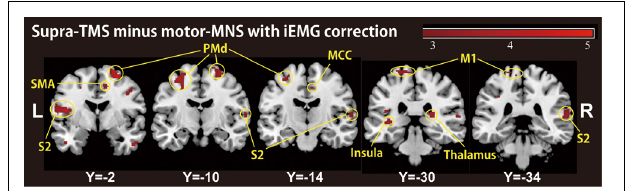
FIGURE 2 | A group-level statistical parametric map categorically comparing hemodynamic changes of the supra-TMS- and motor-MNS-induced activity after iEMG correction ( P < 0 . 005 uncorrected for display purpose), corresponding to “pure” TMS-evoked activity. This activity was observed in bilateral insula, bilateral secondary somatosensory area (S2), bilateral thalami, left primary motor cortex (M1), bilateral dorsal premotor cortex (PMd), supplementary motor cortex (SMA) and middle cingulate cortex (MCC). ( P = 0 . 043 by Mann-Whitney U test). This indicates that